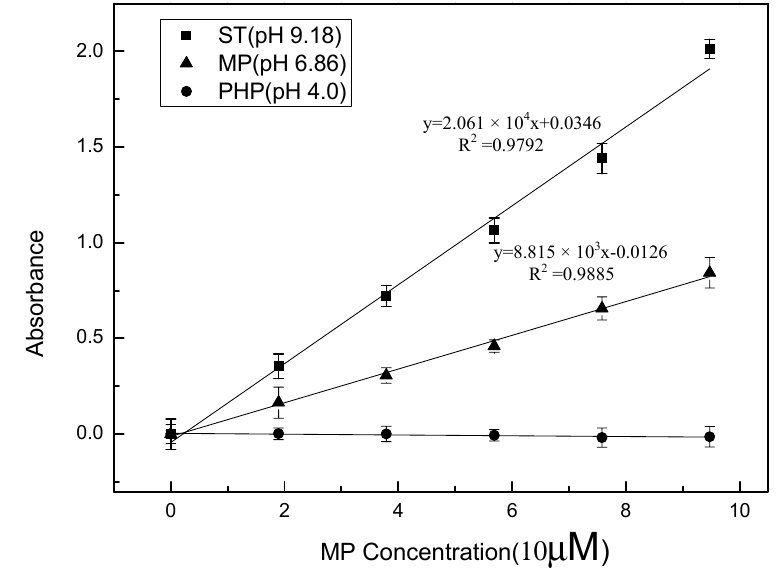
Figure 3. Enzymatic activity of MPH in aqueous solutions against MP concentration in different pH buffers. Three detection times are employed for generating the error bars and the same for the following Figures 4 and